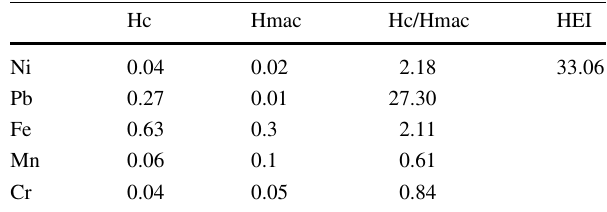
Table 9 Heavy metal evaluation index for groundwater at site 7